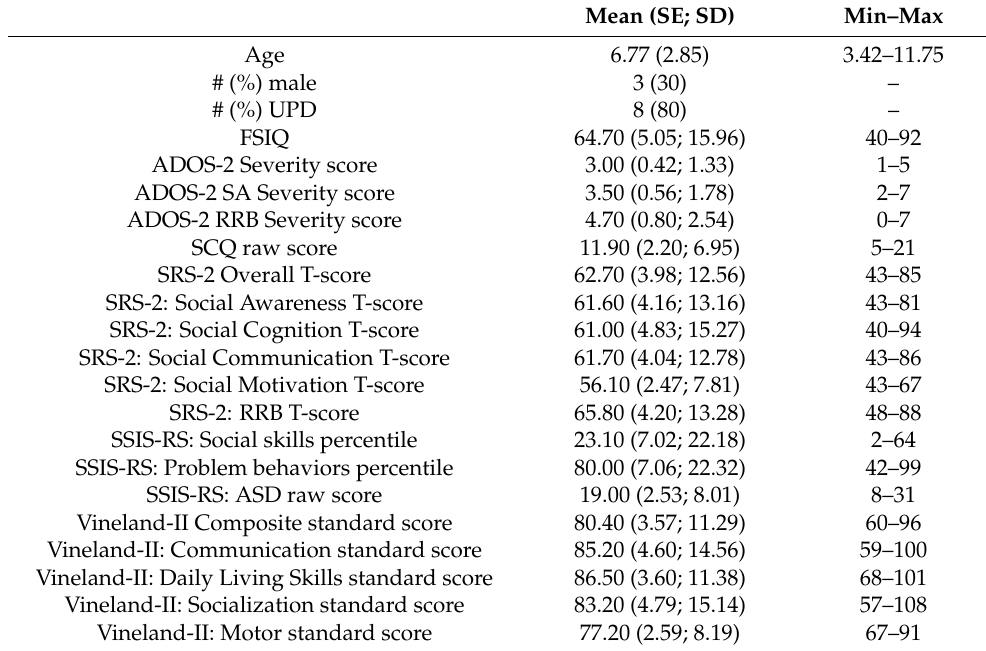
Table 1. Results from assessments, given as mean (SE; SD) and